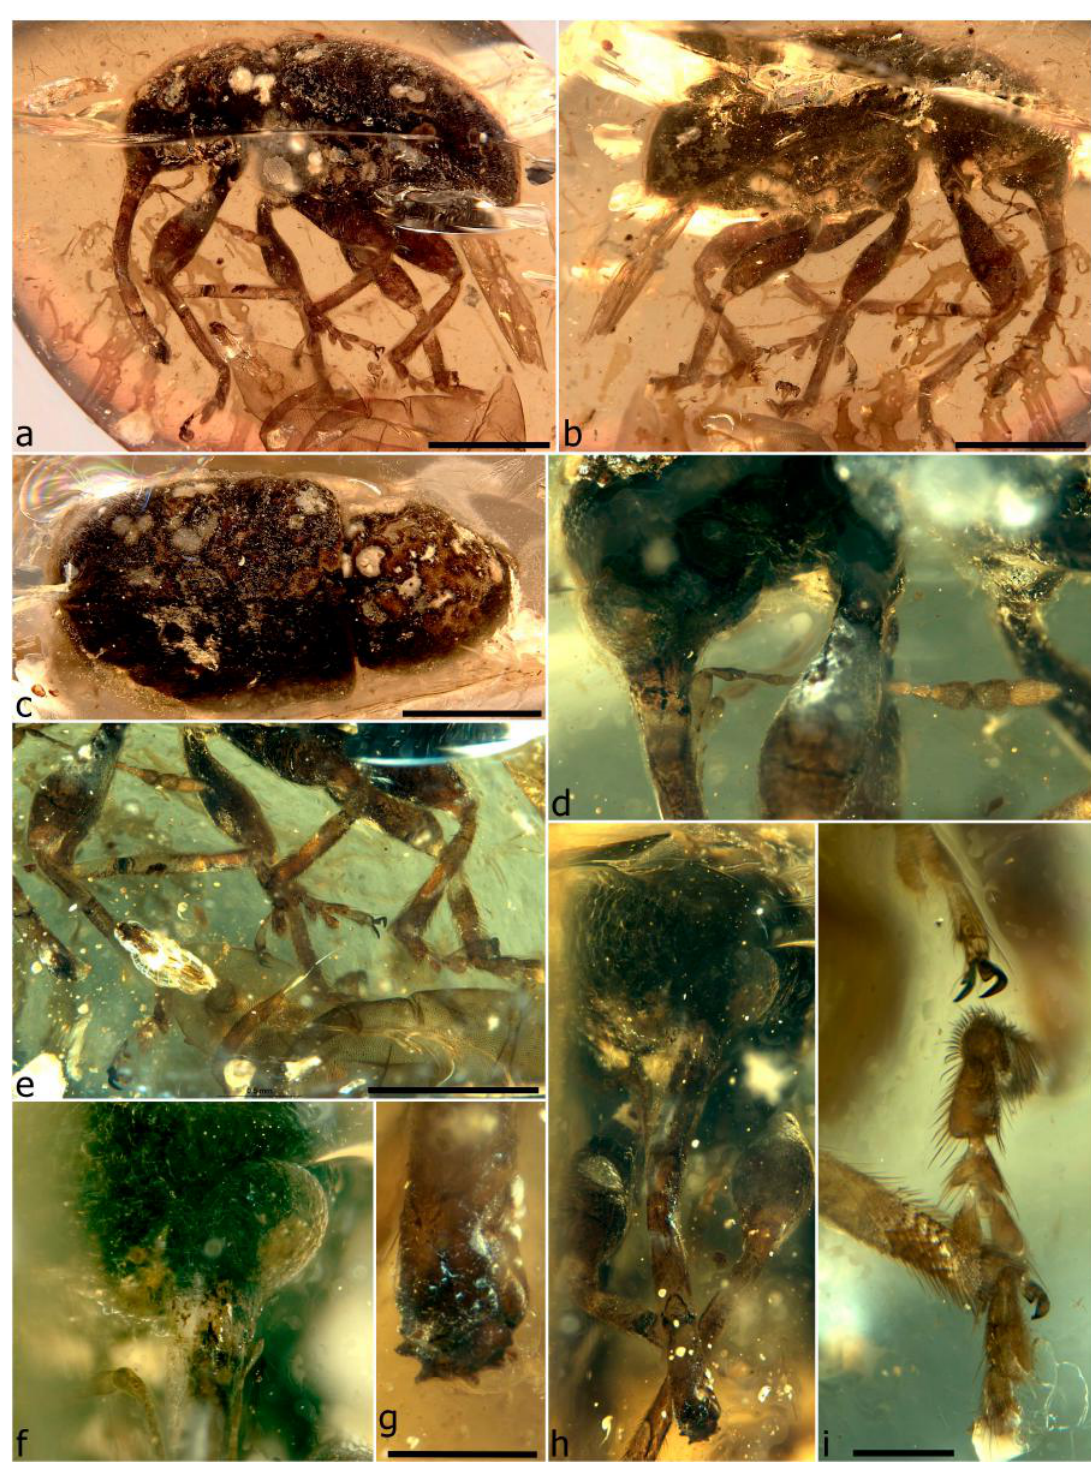
Figure 55. Hukawngius crassipes sp. n., holotype. Habitus, left lateral ( a ); habitus, right lateral ( b ); habitus, dorsal ( c ); head and antenna, left lateral ( d ); legs ( e ); eyes, frontal ( f ); apex of rostrum and mandibles, dorsal ( g ); head, frontal ( h ); tarsi, ventral ( i ). Scale bars: 1.0 mm (a–c,e); 0.2 mm (g,i).